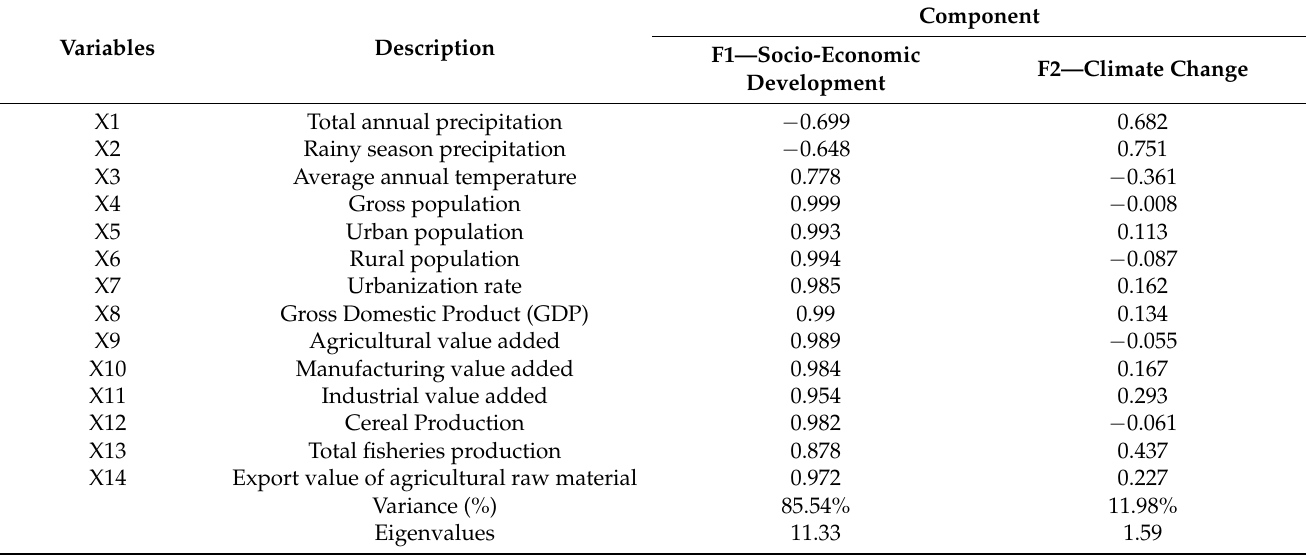
Table 5. Rotated component matrix of the PCA.